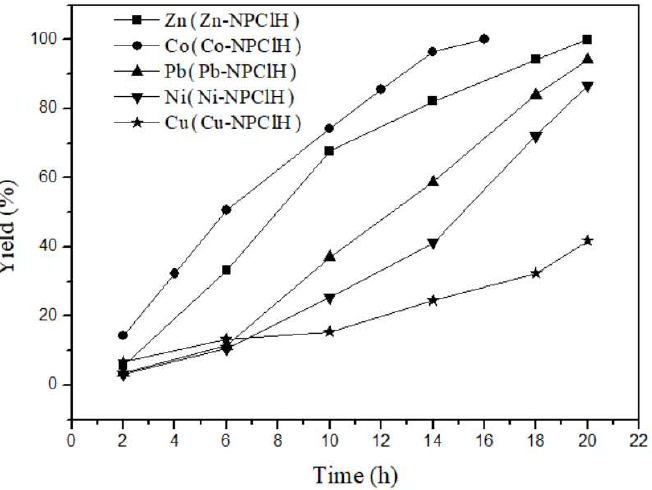
Figure 2. The quaternary ammonium catalyst system reaction of carbon dioxide and glycidyl iso- propyl ether at atmospheric pressure. Reaction conditions: glycidyl isopropyl ether (5 mL, 0.071 mol), catalyst Zn-NPClH (0.71 mmol, 1 mol%), T = 120 °C, P = 0.1 MPa. The selectivity of PC was > 99%.